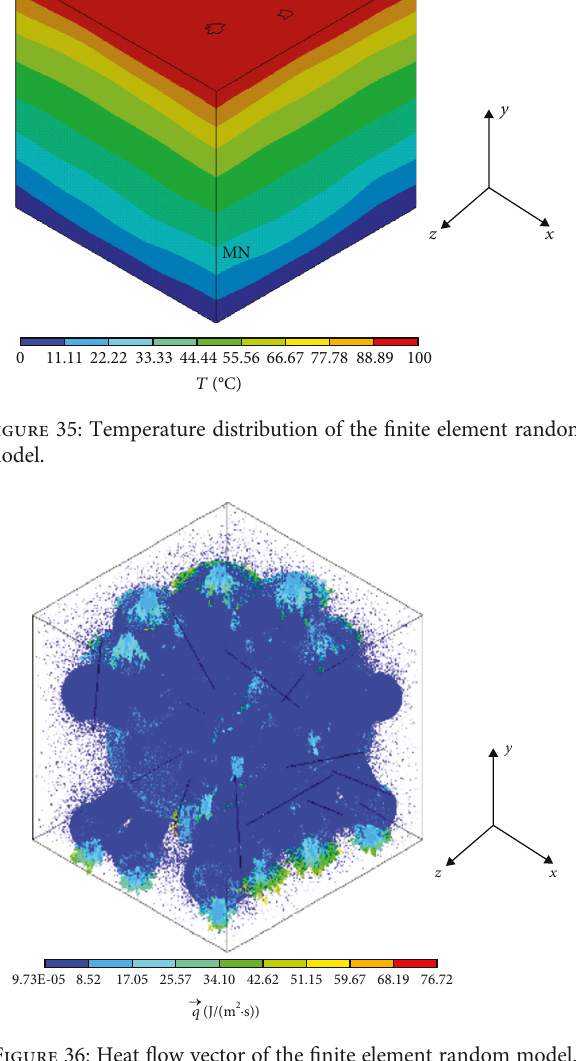
Figure 36: Heat fl ow vector of the fi nite element random